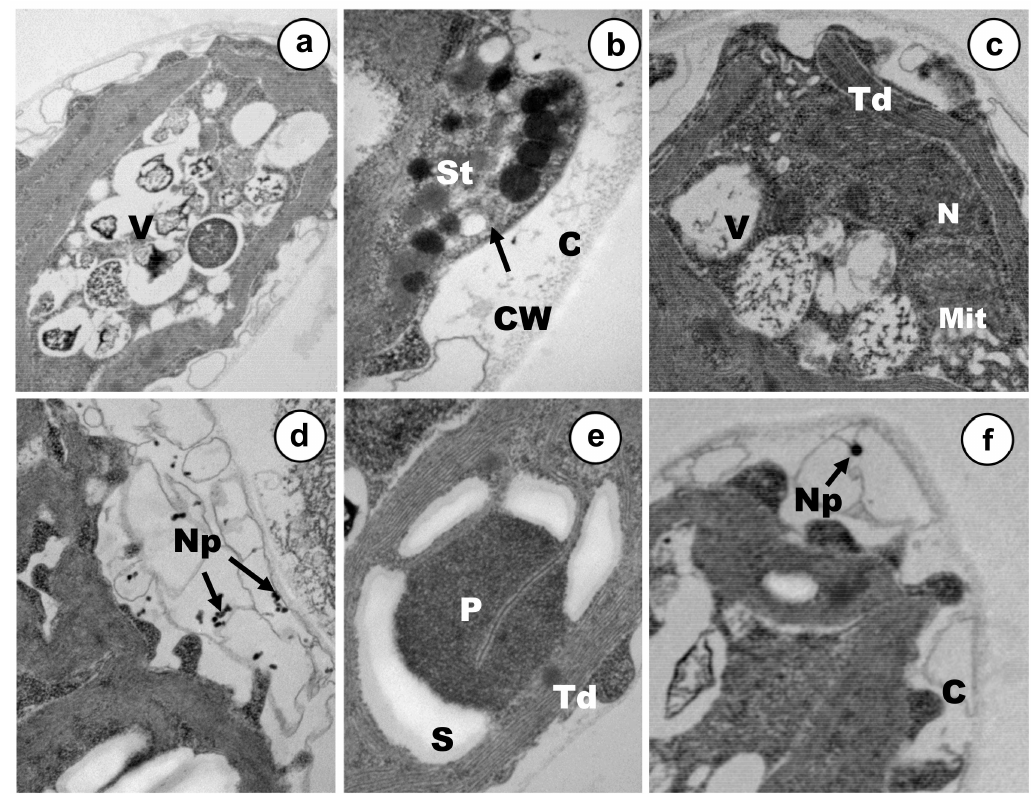
Figure 4. Ultrastructure of arsenate treated vegetative cells. ( a ) Intense vacuolization and bioaccumulation, (15k × ). ( b ) Stigma degeneration, (50k × ). ( c ) Details of the particulate vacuolar content, capsule growth and nuclear alteration, (25k × ). ( d ) Nanoparticle-like formation inside cytoplasmic vacuoles, (50k × ). ( e ) Strong starch accumulation around the pyrenoid, (50k × ). ( f ) Nanoparticle-like entrapped in the capsule, (25k × ). S—Starch deposits; P—pyrenoid; St—stigma; V—vacuole; Td—thylakoids; C—capsule; Np—nanoparticles-like (Np); Mit—mitochondria; CW—cell wall;